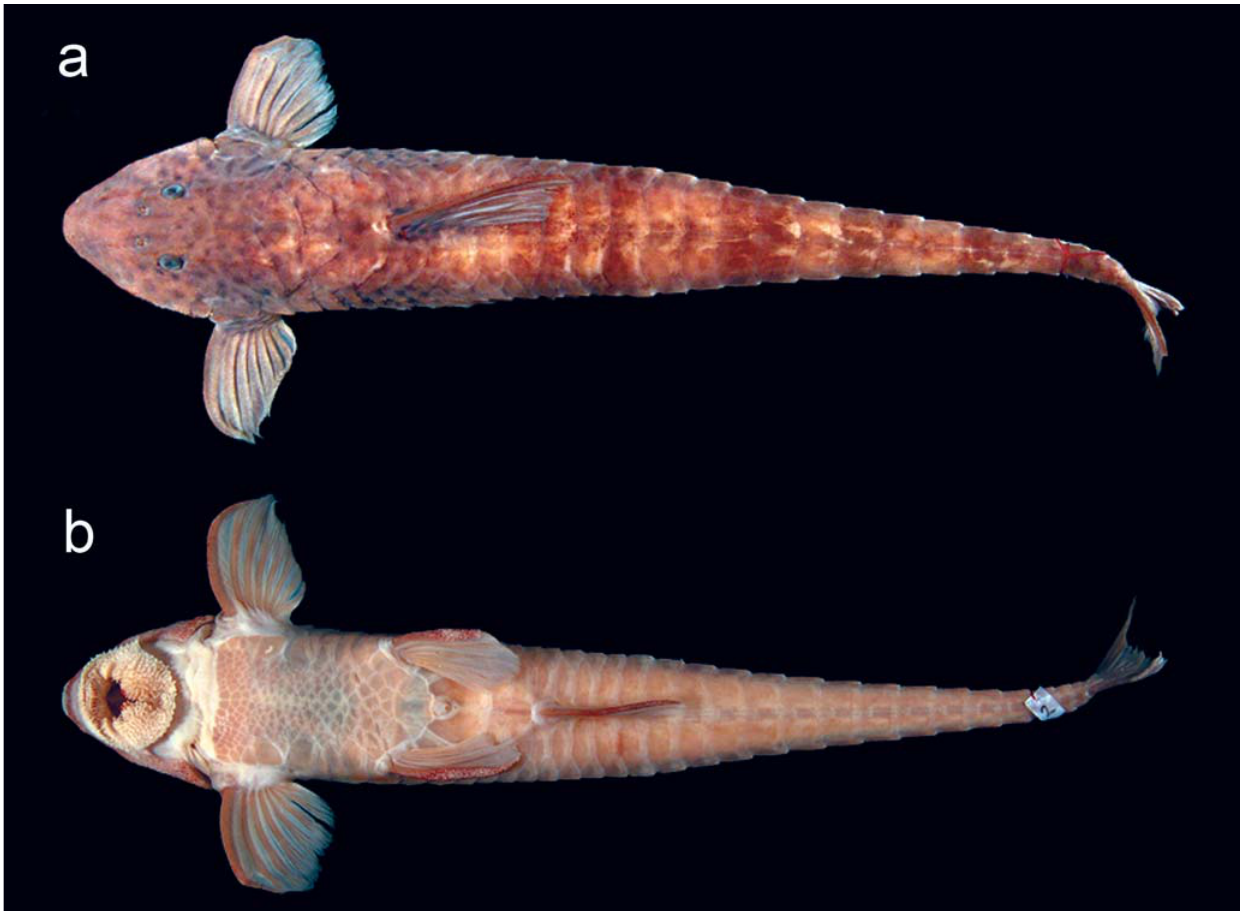
Fig. 1. Rineloricaria daraha . holotype. INPA 28579; 200.9 mm SL; Brazil, Amazonas, rio Daraá, Aracu